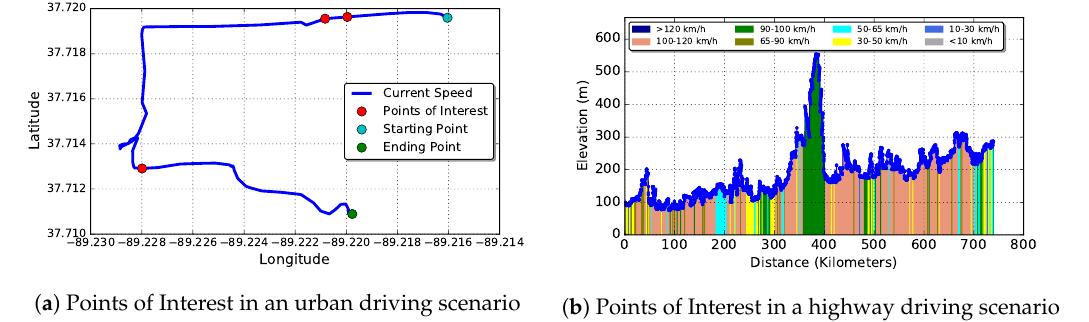
Figure 3. Points of Interest extracted from on-route information in an urban and a highway driving